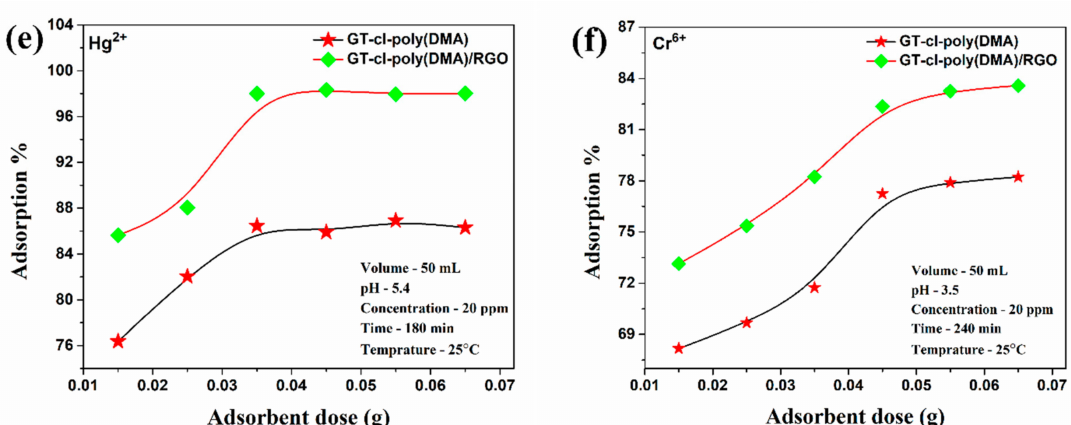
Figure 6. Influence of ( a ) RGO loading on Hg 2 + adsorption ( b ) RGO loading on Cr 6 + adsorption, ( c ) pH on adsorption of Hg 2 + , ( d ) pH on adsorption of Cr 6 + , ( e ) adsorbent dose on adsorption of Hg 2 + , ( f ) adsorbent dose on adsorption of Cr 6 + . Adsorbent: gum tragacanth-cl- N,N - dimethylacrylamide (GT-cl-poly(DMA)) hydrogel and reduced graphene oxide incorporated gum tragacanth-cl- N,N -dimethylacrylamide (GT-cl-poly(DMA) / RGO) hydrogel